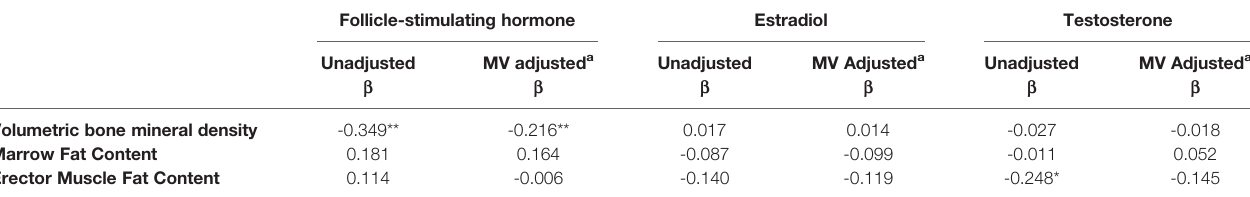
TABLE 3 | Multivariate linear regression analysis showing the factors determining vBMD and fat measurements.